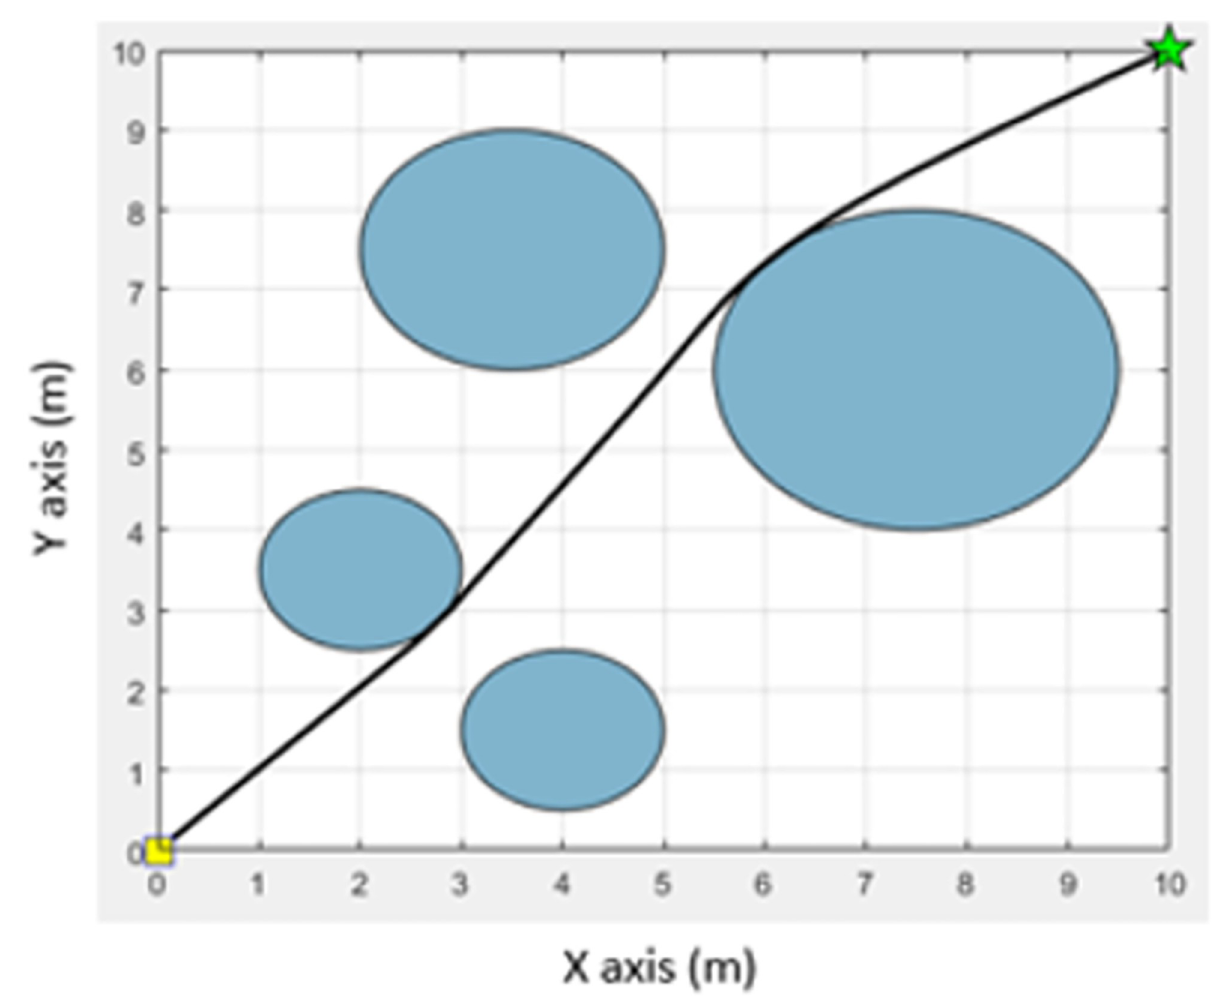
Fig 28. The path obtained from the MOEPSO algorithm in a static environment (4 obstacles).